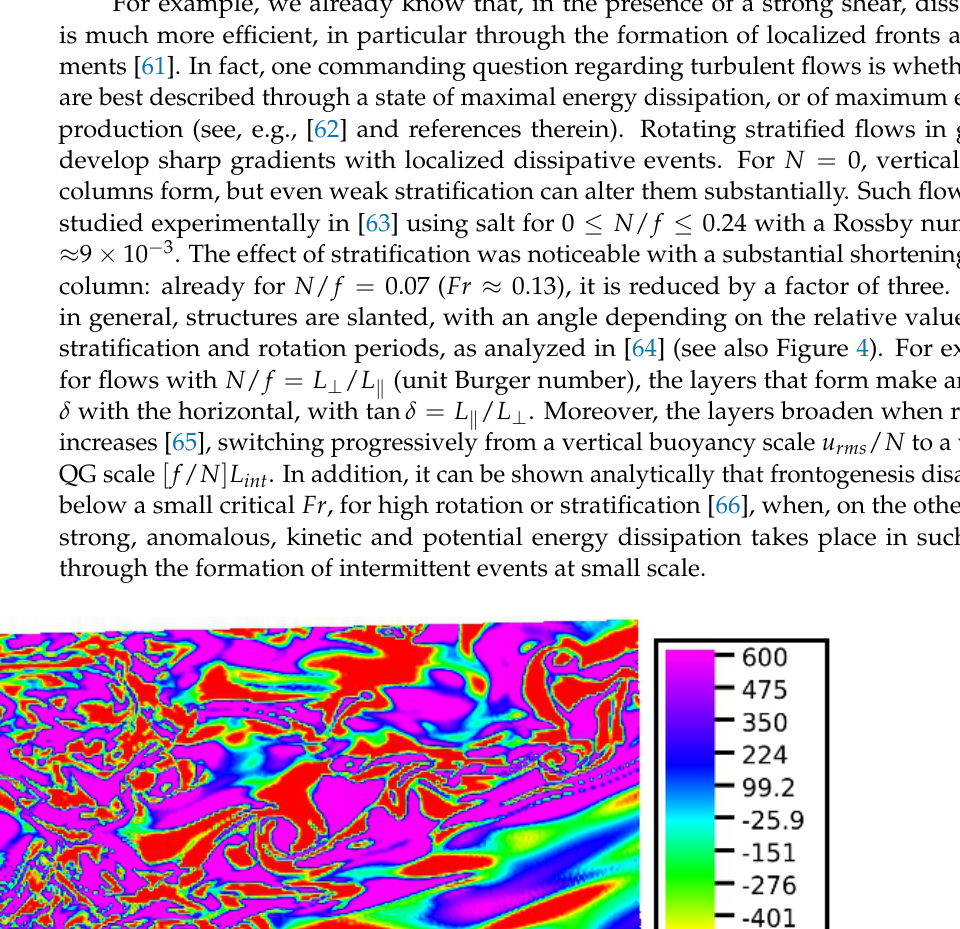
Figure 5. Joint probability of point-wise buoyancy flux normalized by N , B f ( x ) / N = w ( x ) θ ( x ) , and of gradient Richardson number Ri g ( x ) for runs rI, rII and rIII, respectively left, middle and right (see Table 1). Note the extended range of values for Ri g in the left panel. AP: Normalize dor not, see equ.7 In order to examine the relationship between dissipation and mixing, we show now joint PDFs of 225